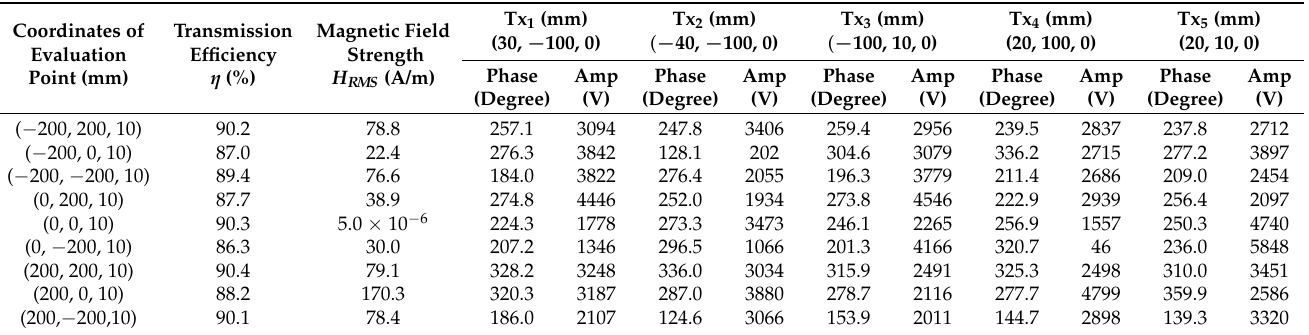
Figure 11. Color map ( α = 0.9, 5 Tx coils): ( a ) transmission (Tx) coil configuration and magnetic field strength map and ( b ) transmission efficiency map. The Tx coil configuration was as follows: Tx 1 , (30, − 100, 0) mm; Tx 2 , ( − 40, − 100, 0) mm; Tx 3 , ( − 100, 10, 0) mm; Tx 4 , (20, 100, 0) mm; Tx 5 , (20, 10, 0) mm. Table 4. Coordinates of evaluation points and transmission (Tx) coil arrangement and phase and amplitude of input voltage ( α = 0.9, 5 Tx